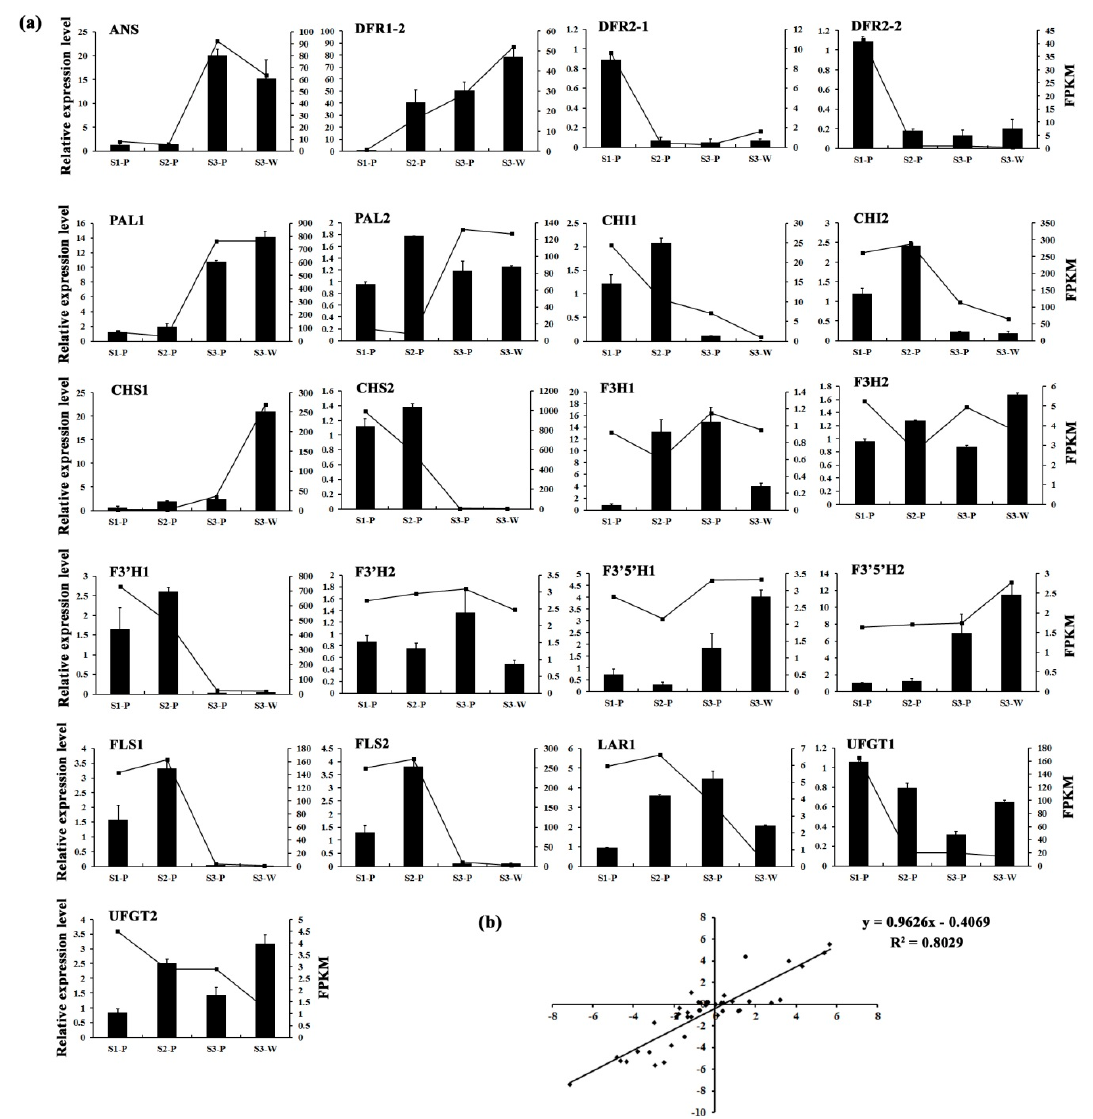
Figure 3. The qRT-PCR validation of DEGs. ( a ) The relative expression levels of 21 pigmentation-related candidate unigenes. The left y -axis denotes the relative transcript amount obtained by qRT-PCR. The right y -axis represents the fragments per kilobase per million fragments (FPKM) value of each gene using RNA-Seq analysis. Error bars indicate the standard errors. ( b ) Correlation analysis of the gene expression value from RNA-Seq and qRT-PCR.